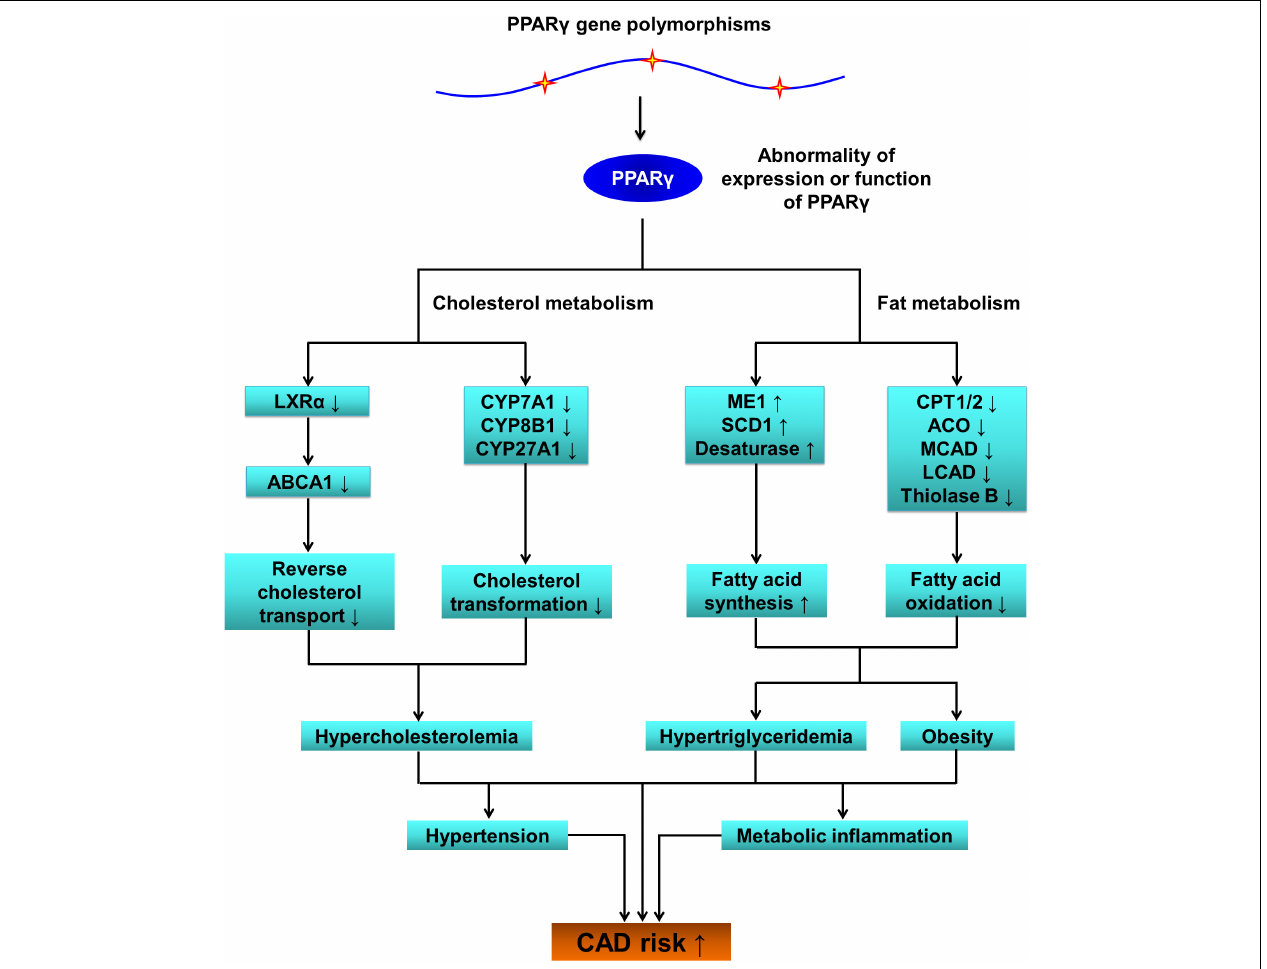
FIGURE 2 | The pathophysiological role of PPARG SNPs in coronary artery disease (CAD). PPARG , peroxisome proliferator-activated receptor gamma gene; PPAR γ , peroxisome proliferator-activated receptor gamma; LXR α , liver X receptor alpha; ABCA1, ATP-binding cassette transporter A1; CYP7A1, cytochrome P450 family 7 subfamily A member 1; CYP8B1, cytochrome P450 family 8 subfamily B member 1; CYP27A1, cytochrome P450 family 27 subfamily A member 1; ME1, malic enzyme 1; SCD1, stearoyl-coenzyme A desaturase 1; CPT1/2, carnitine palmitoyltransferase 1/2; ACO, acyl-coenzyme A oxidase; MCAD,